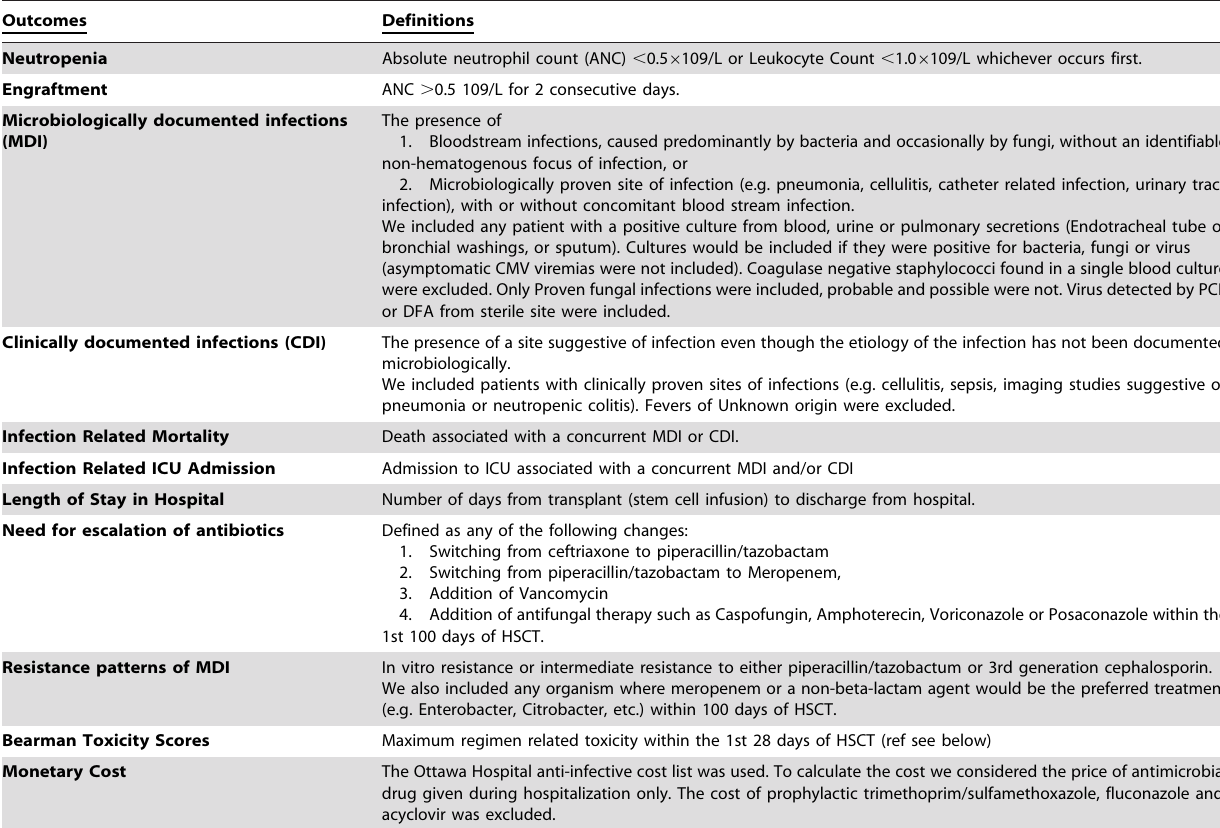
Table 1. Definition of